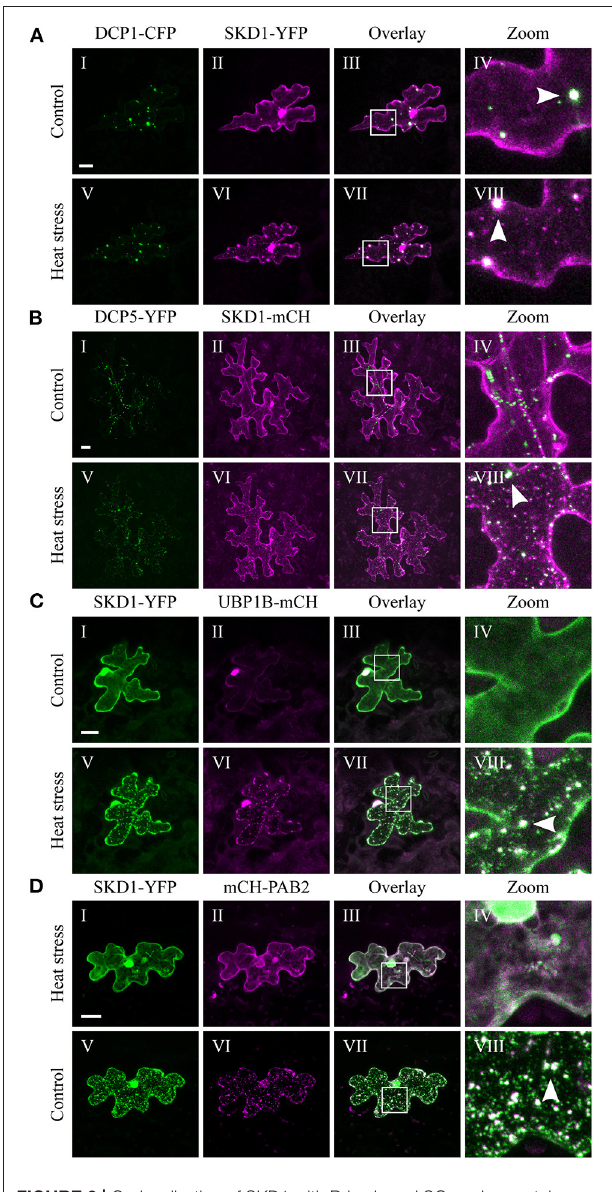
FIGURE 2 | Co-localization of SKD1 with P-body and SG marker proteins. Representative images of transiently transformed epidermal leaf cells that co-express SKD1-YFP or SKD1-mCH with P-body markers (A) DCP1-CFP or (B) DCP5-YFP, or SG marker UBP1B-mCH (C) or mCH-PAB2 (D) before (I–IV) and after heat treatment (V–VIII). For clarity, the DCP1-CFP signal is also depicted in green. Arrows indicate co-localizing structures (VIII). Scale bar = 20 µ